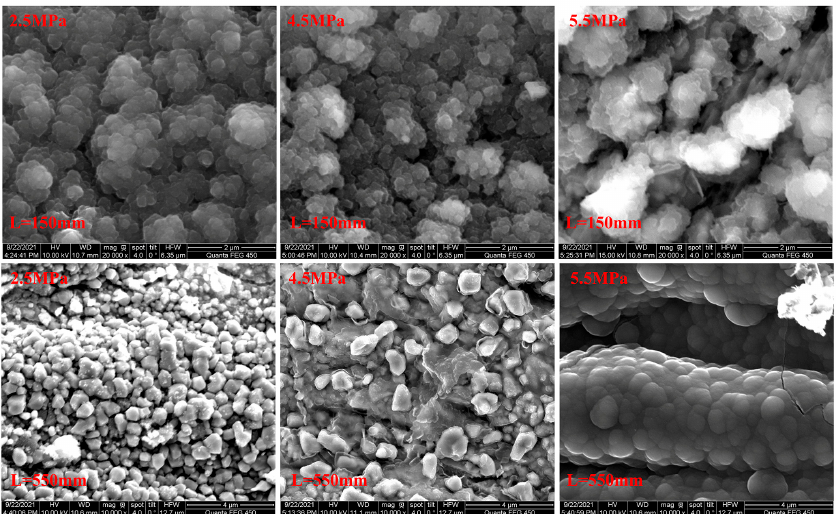
Figure 12. Morphologies of deposits under a heat flux of 0.2 MW/m 2.